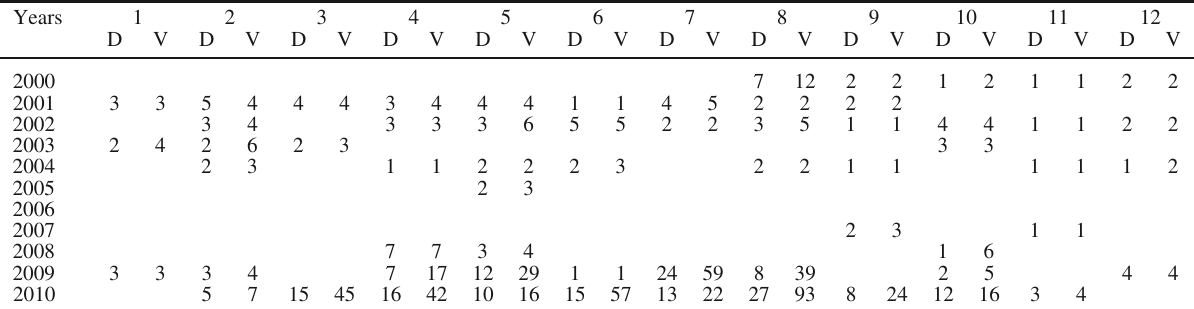
Table 3. – Sampling days (D) and number of fishing vessels sampled (V) on the Pacific coast of Baja California Sur for the present study. The numbers represent months of the year from January (1) to December (12) during the period 2000-2010.